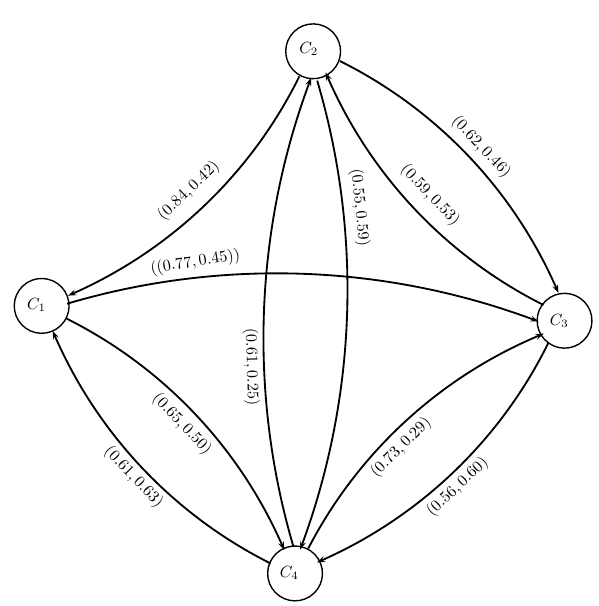
Figure 13. Partial directed network of the fused